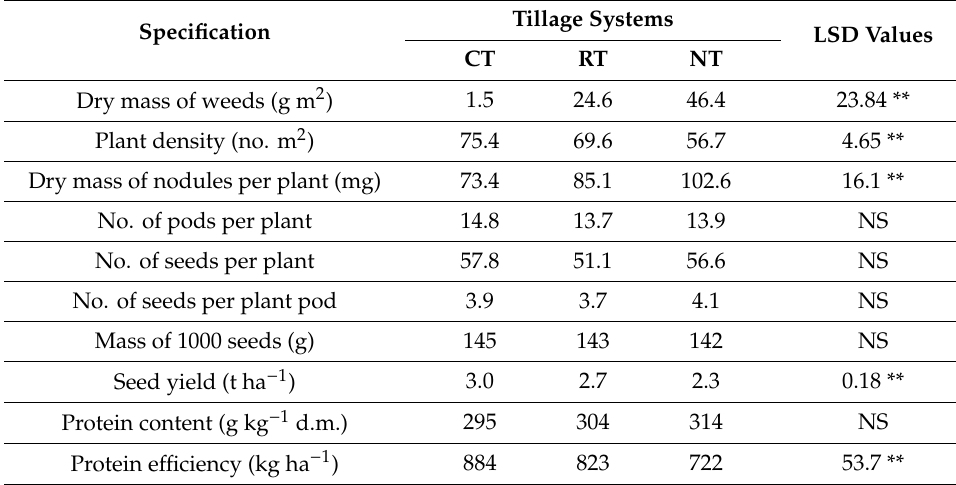
Table 4. E ff ect of soil tillage system on weed infestation, narrow-leaved lupin (NL) development and